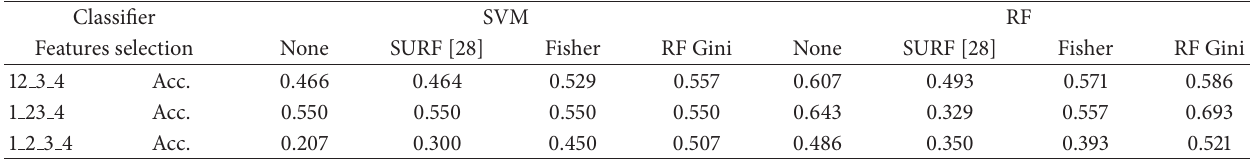
Table 8: Quality robustness assessment (accuracy) for